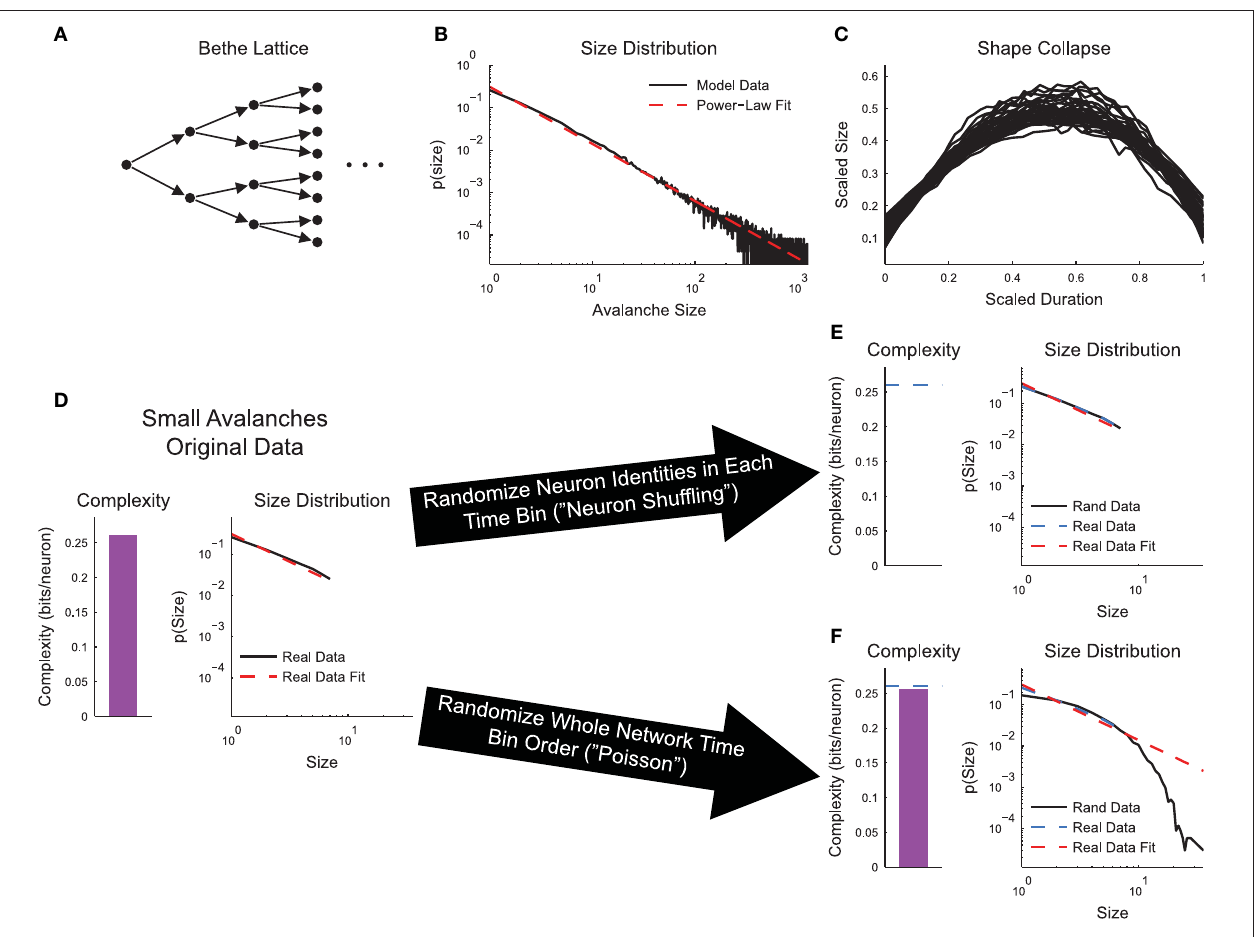
FIGURE 5 | Neural complexity and criticality are not trivially related. (A) Bethe Lattice or branching model. Activity spread from layer to layer starting at the leftmost neuron. The likelihood to transmit activity along a connection was p trans = 0.5, yielding a critical model system. (B) The avalanche sizes in the model were power-law distributed, as expected. (C) The avalanches exhibited shape collapse, as expected. (D–F) Analysis of small avalanches (stopped on or before the 8th layer). (D) The small avalanches exhibited power-law distributed sizes and non-zero complexity. (E) Randomizing the neuron identities (“neuron shuffling”) at each time bin preserved avalanche size distribution, but removed complexity. (F) Randomizing the order of the network states (“Poisson” randomization applied to whole network states) preserved complexity, but disrupted the avalanche size distribution.